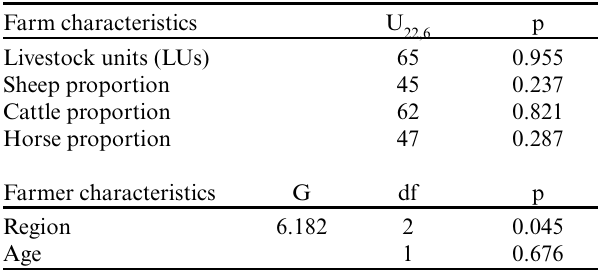
Table 2 . Result of tests of the numbers of farmers that were either willing or unwilling to both manage grazing and spare important land to benefit birdlife in relation to their farm characteristics (Mann-Whitney tests), region (G-test), and age (older or younger than the median birth year of 1966, Fisher’s exact